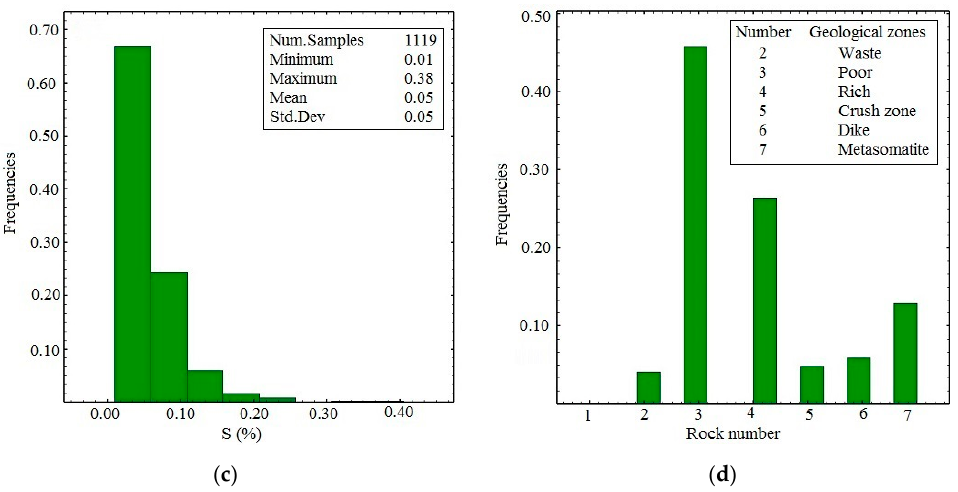
Figure 3. Histograms of borehole samples obtained from Fe (%) ( a ), P (%) ( b ), S (%) ( c ) and the distribution of borehole samples in each geologic domain ( d ). Table 1. Statistics of the grades.